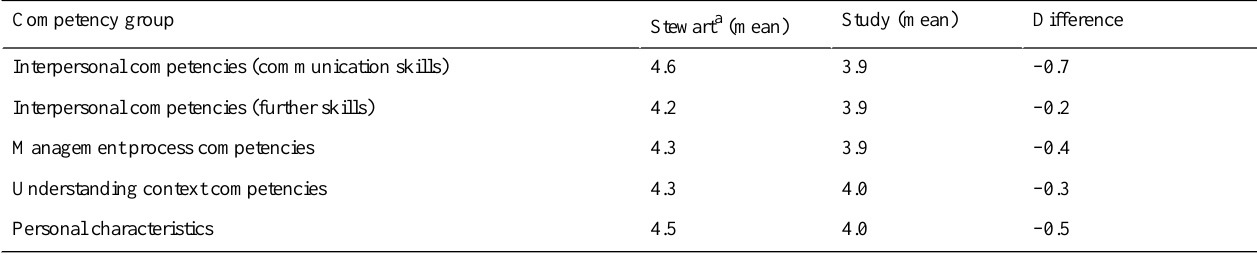
Table 4. Difference of prioritization compared to Stewart [33] per competency